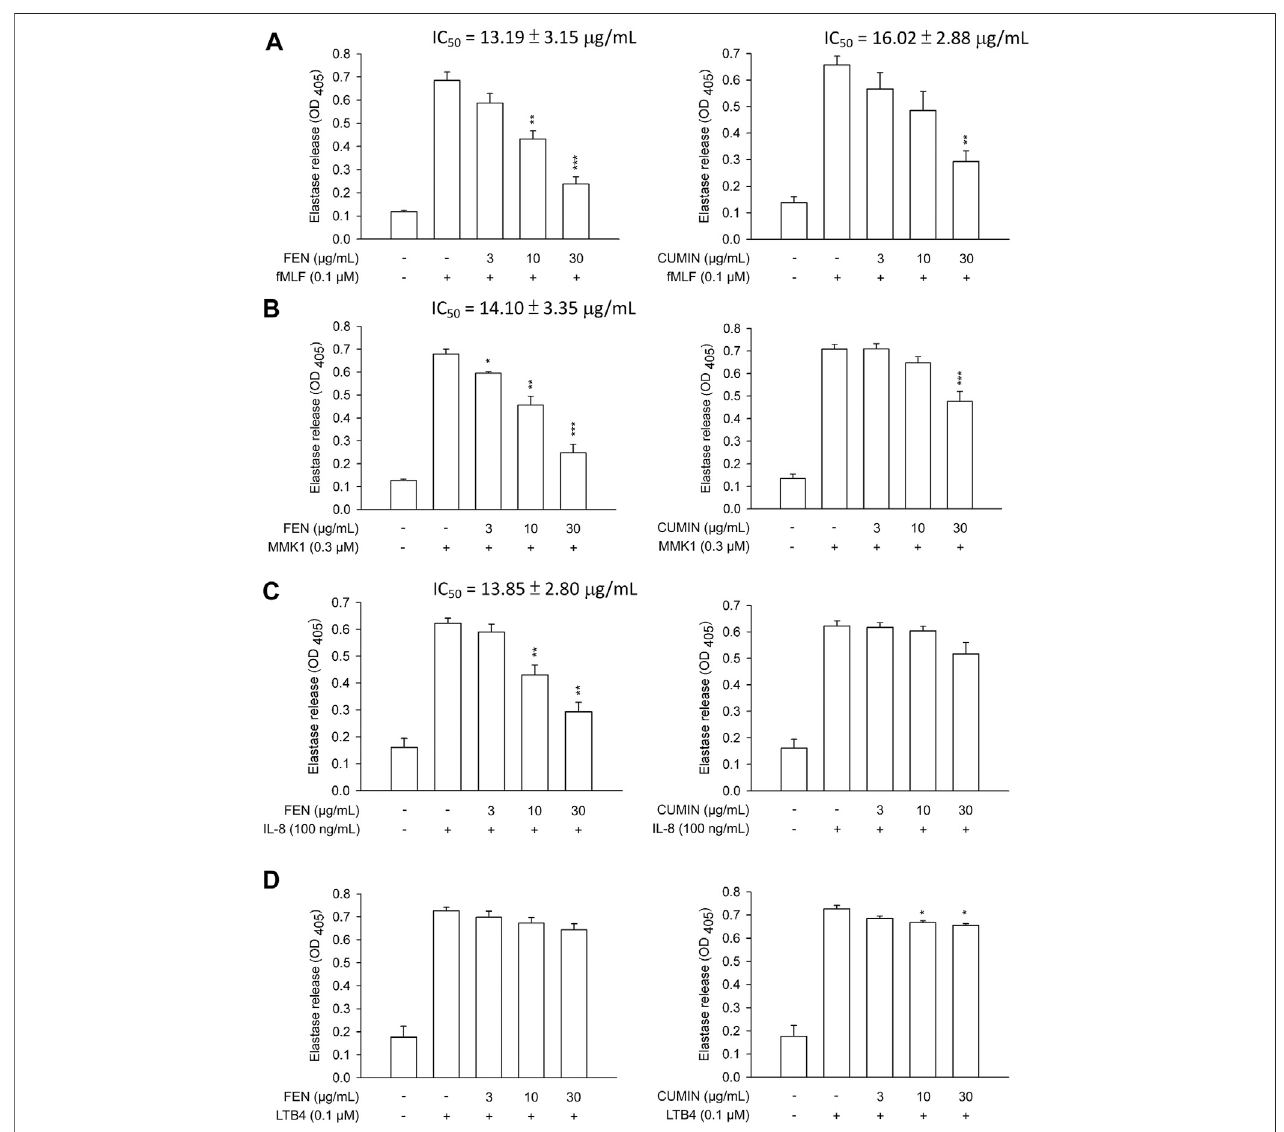
FIGURE 2 | Effects of fennel (FEN) (left panel) and cumin (CUMIN) (right panel) volatile oils on degranulation in human neutrophils using various inducers. Human neutrophils were incubated with 0.1% DMSO (as control), fennel or cumin volatile oils for 5 min, and then activated by (A) fMLF, (B) MMK1, (C) IL-8, or (D) LTB4 in the presence of CB for another 10 min (details in Measurement of Elastase Release ). Elastase release was measured based on consumption of the substrate present in the medium and OD was read at 405 nm. Data are expressed as mean ± S.E.M. ( n (cid:2) 3). * p < 0.05; ** p < 0.01; *** p < 0.001 compared with the control (inducer only).